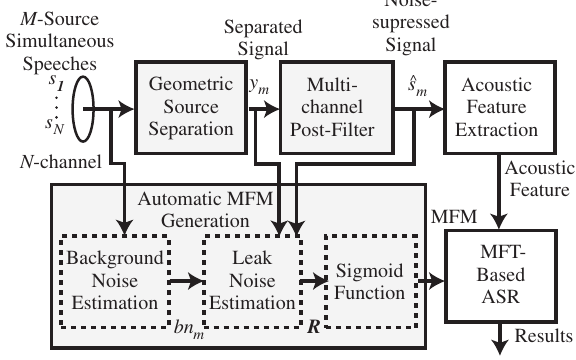
Figure 1. Geometric source separation with multi-channel